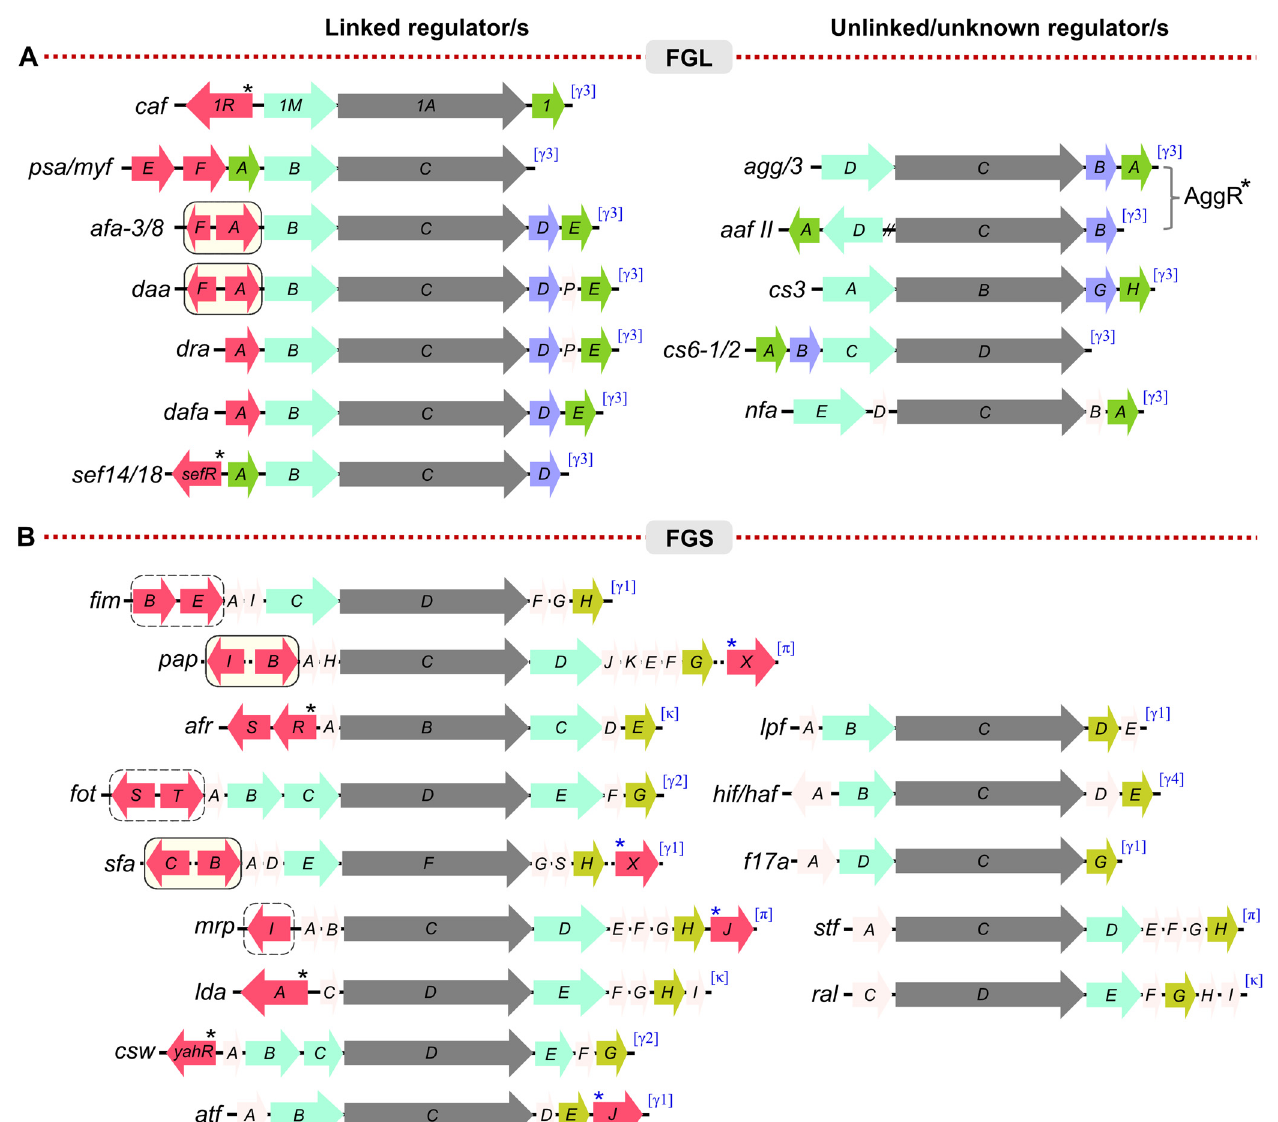
Figure 1. Diversity in gene-cluster of the CUP assembled fimbriae of Gram-negative bacteria. Selected fimbrial clusters and regulator genes of the structurally and functionally distinct groups, FGL ( A ) and FGS ( B ), where the F 1 -G 1 loop of the chaperone is either Long (as in FGL) or Short (as in FGS). Coloured arrows indicate the orientation of each gene encoding; red (regulator/s where identified), cyan (periplasmic chaperone), grey (outer membrane usher), apple green (adhesin, FGS), jade green (major subunit/adhesin, FGL), purple (additional subunit/invasin, FGL), light pink, additional pilin subunits (FGS) or protein/s of unknown function (FGL). DNA binding regulators belonging to the A/X family of transcriptional factors are indicated by black (*) asterisk, with blue asterisk indicating mrpJ homologues. Regulation by recombinases/promoter inversion is depicted in enclosed dashed boxes. Epigenetic regulation, via Dam-methylation, is indicated by beige boxes with solid lines. Gene clusters are from Escherichia coli , except caf, psa ( Yersinia pestis ); lpf , sef, stf ( Salmonella spp.); mrp , atf ( Proteus mirabilis ); hif / haf ( Haemophilus influenzae ). Gene clusters originally sourced from Zav’yalov et al. [24], and adapted [8,18,35,37–44].